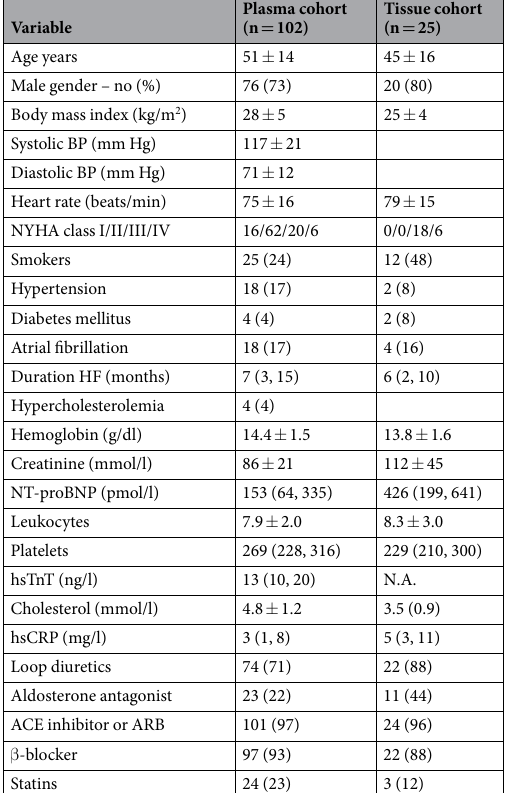
Table 1. Characteristics of patients with idiopathic DCM (n = 102) and end-stage DCM who underwent heart transplantation (n = 25). Patient characteristics are presented as mean ± standard deviation or median (25 th /75 th percentile) for continuous variables and % of cases for categorical variables. BP, blood pressure; HF, heart failure; hsCRP, high-sensitivity C-reactive protein; hsTnT, high-sensitive troponin T; NT-proBNP, N-terminal pro-brain natriuretic peptide; NYHA, New York Heart